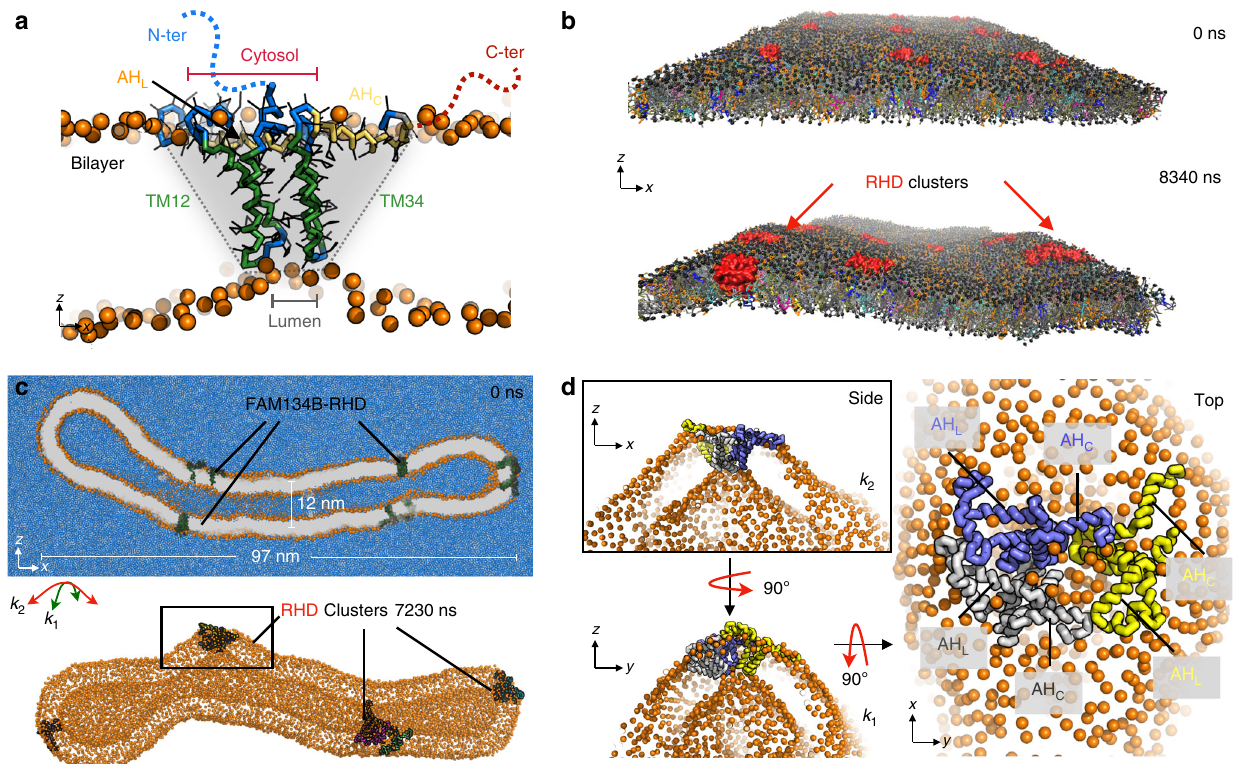
Fig. 5 RHD unique topology drives curvature and clustering in membranes. a Snapshot from coarse-grained simulation. The FAM134B-RHD forms a wedge-shaped protein inclusion (gray shade) in the membrane (orange PO4 beads). Local bilayer thinning by short hairpins (TM12 and TM34; green) promotes inter-hairpin interactions (blue) at the luminal lea fl et (see Supplementary Fig. 19). AH L (orange/yellow sticks) separates the two hairpins on the cytosolic lea fl et and, along with AH C (yellow sticks) enhances curvature. b Simulation snapshots showing local clustering of multiple FAM134B-RHD molecules (red) on model ER membrane under periodic boundary conditions (see Supplementary Fig. 21). c Cross section of a closed tubular structure ( k 1 ≈ 0.16 nm − 1 ; k 2 ≈ 0 nm − 1 ; gray with orange PO4 beads) containing 10 FAM134B-RHD molecules simulated in explicit solvent (~3.6 × 10 6 water beads; blue). Deformed tubule structure (below) after ≈ 7 μ s showing organization of RHDs into three local clusters. d Zoom-in on the boxed cluster